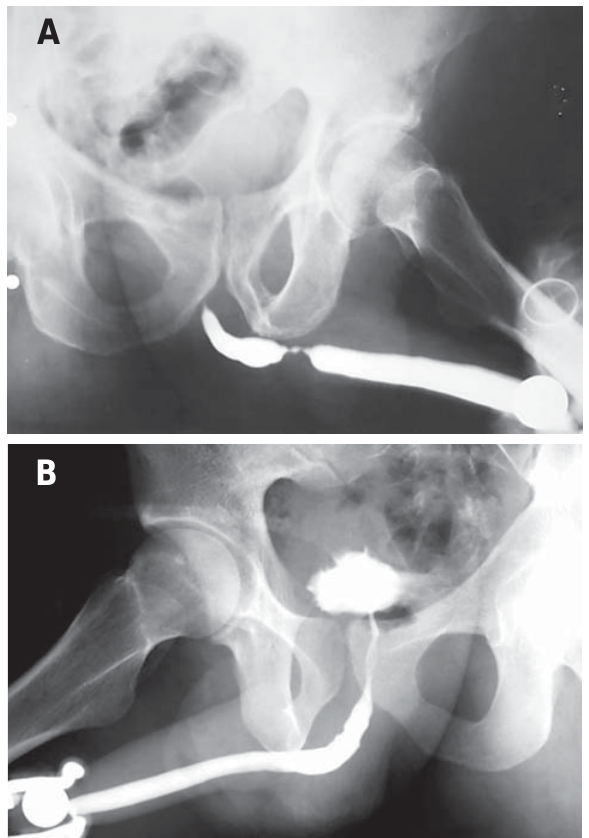
Figure 6 – A) Voiding cystourethrogram showing a stricture. B) Voiding cystourethrogram after tunica vaginalis